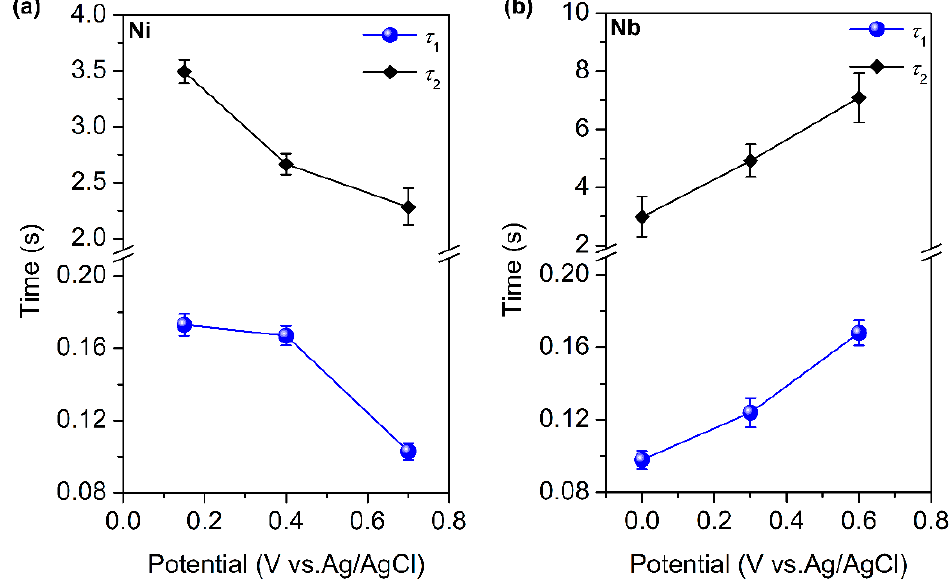
Figure 11. Parameters of repassivation kinetics obtained by fitting the current curves during the scratching tests: ( a ) Ni and ( b ) Nb.